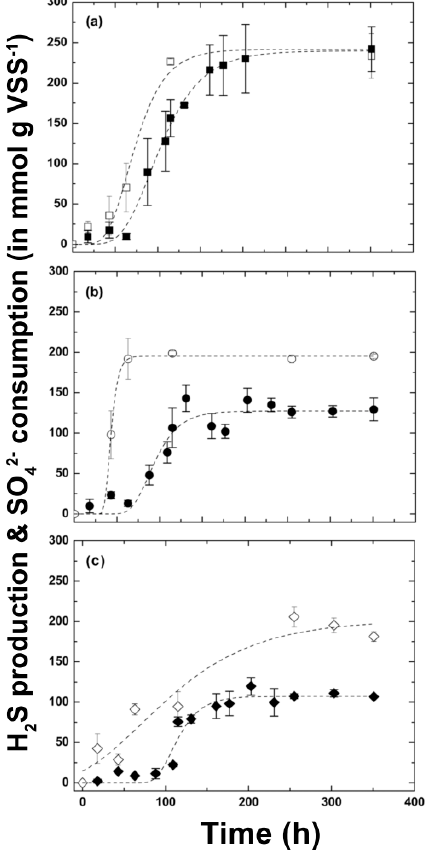
Figure 2. Kinetic test of hydrogen sulfide production (close symbols) and sulfate reduction (open symbols) of sulfidogenic batch reactors inoculated with ( a ) SC469, ( b ) SD636 and ( c ) PD102. The dashed lines represent Gompertz model fitting.